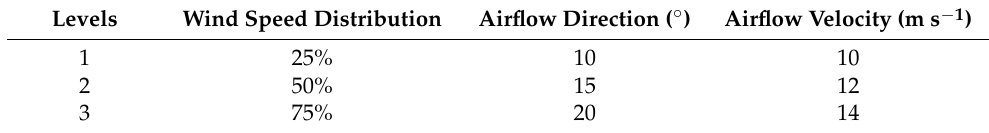
Table 3. Values used in orthogonal experiments.